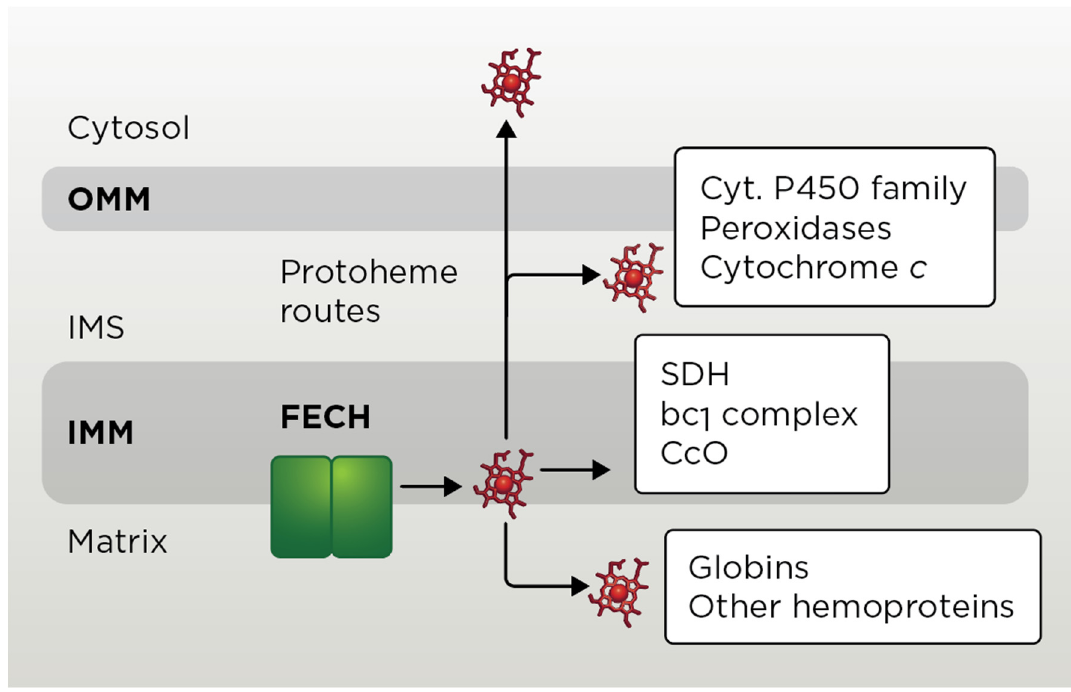
Figure 3. Mitochondrial heme routes. Mitochondrial enzyme ferrochelatase (FECH) metallates PP IX, yielding protoheme that is routed to several suborganellar locales, wherein heme b is sequentially modified and/or inserted into the indicated hemoproteins. SDH, succinate dehydrogenase; CcO, cytochrome c oxidase; OMM, outer mitochondrial membrane; IMS, intermembrane space; IMM, inner mitochondrial membrane.